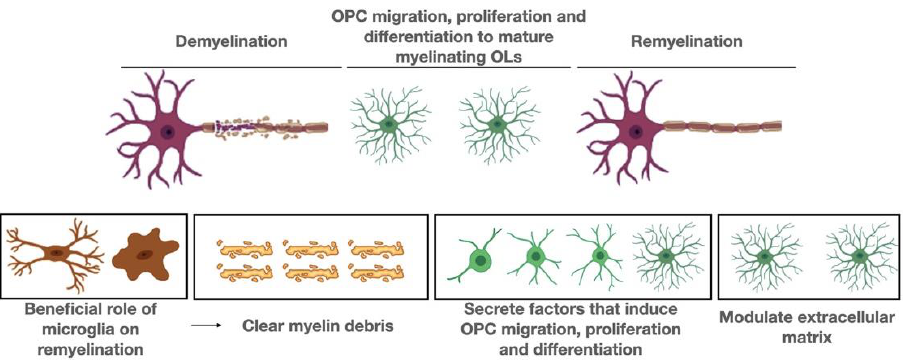
Figure 1. Beneficial role of microglia on remyelination. Microglia promote remyelination in three ways. First, they remove myelin debris, a procedure that is essential for the initiation of remyelination. Second, they secrete factors that promote OPC migration, proliferation and differentiation into mature myelinating oligodendrocytes. Third, they modify the extracellular